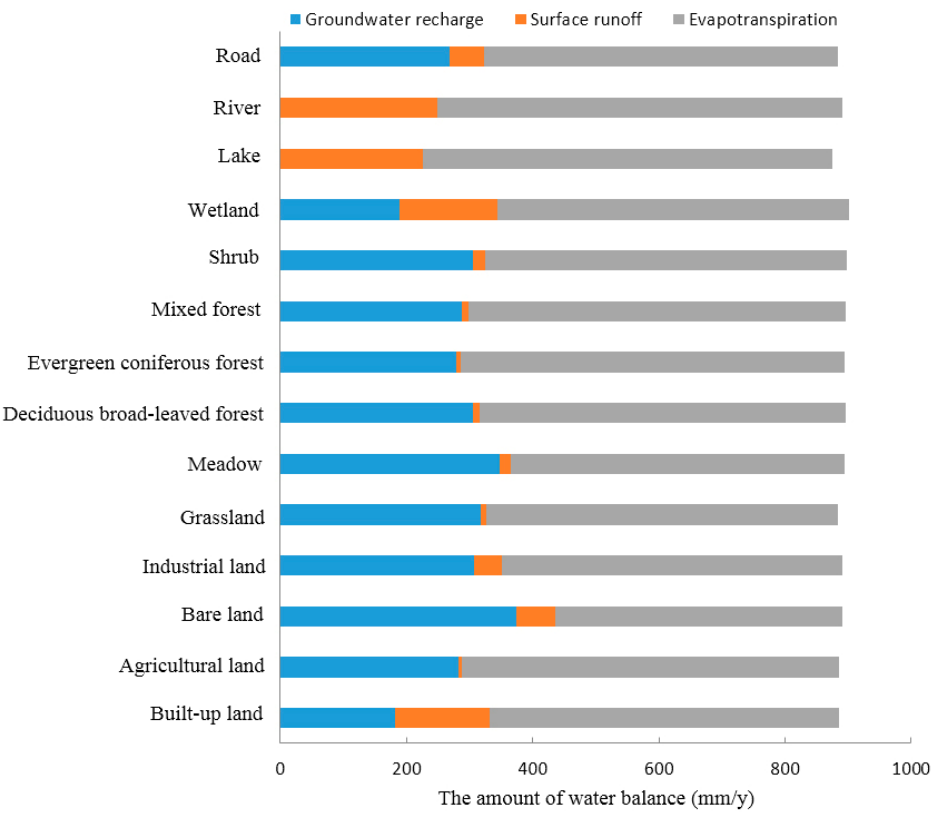
Figure 6. Average annual groundwater recharge, runoff and evapotranspiration for different land-use types.